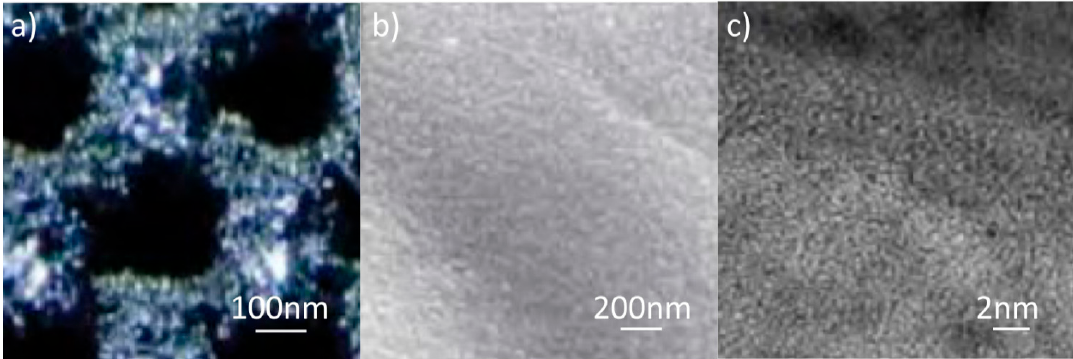
Figure 30. Structure of selectively laser-sintered titanium; ( a ) skeleton topography with a pore diameter of ~450 µm (SEM); ( b ) Ti- α martensite crystal structure in the thin foil (TEM); ( c ) distribution of Ti atoms in Ti- α martensite (HRTEM).